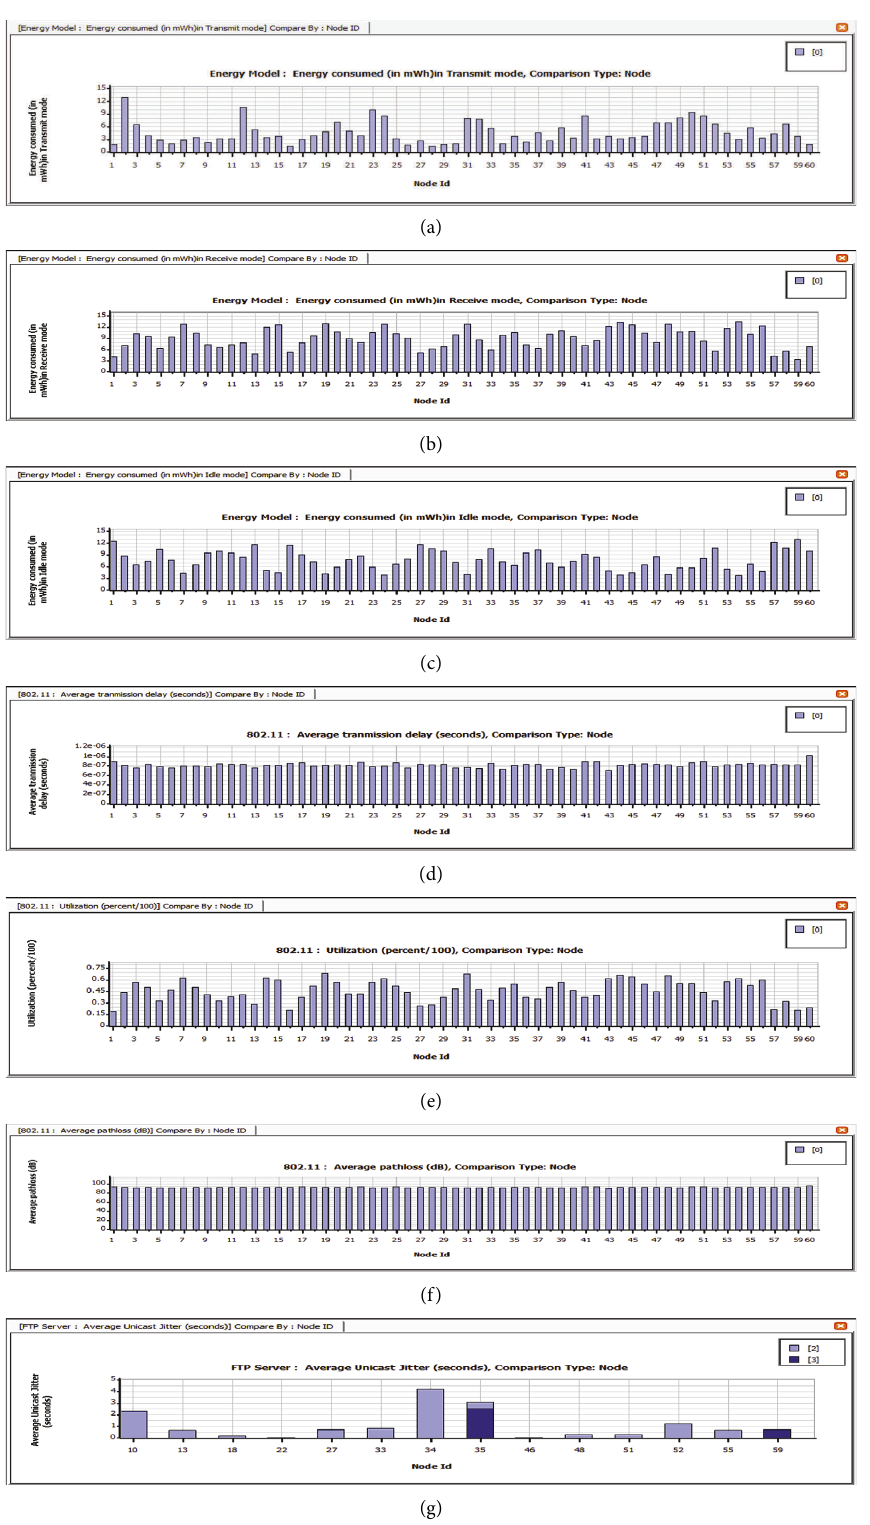
Figure 10: (a) Transmit mode energy consumption of DYMO for FTP deployment. (b) Receive mode energy consumption of DYMO for FTP deployment. (c) Idle mode energy consumption of DYMO for FTP deployment. (d) Average transmission delay of DYMO for FTP deployment. (e) Percentage of utilization of DYMO for FTP deployment. (f) Average pathloss of DYMO for FTP deployment. (g) Average unicast jitter of DYMO for FTP